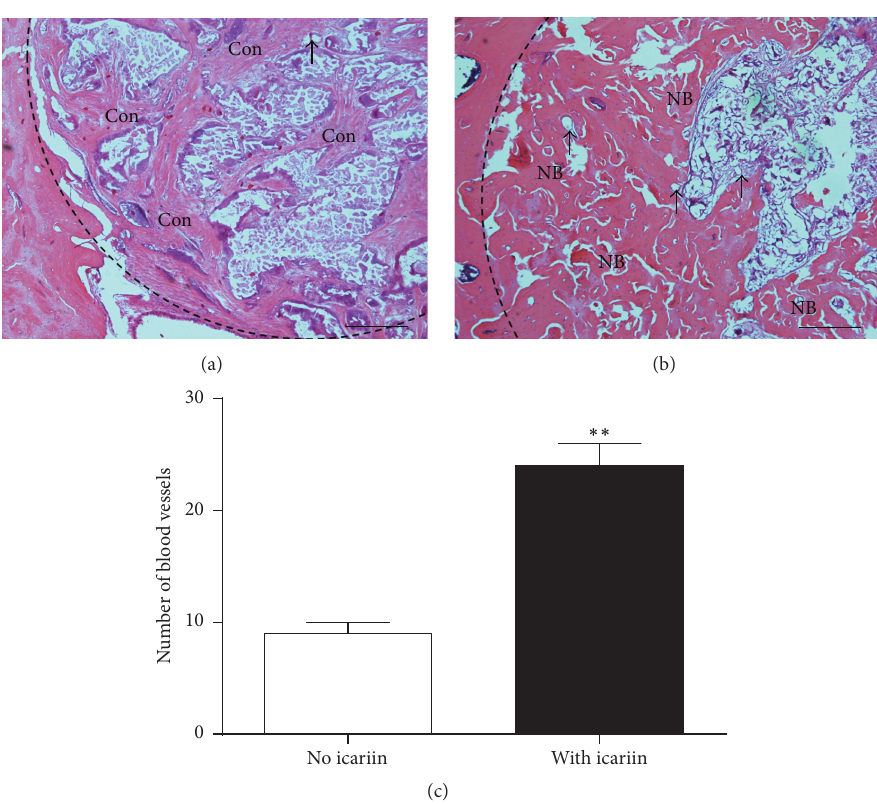
Figure 9: Light micrographs depicting the new bone formation within the calvarial critical-size bone defects that were treated with SMC- PHBHHx/allogeneic BMSCs either (a) without or (b) with icariin. Bar = 200 𝜇 m. Then all data are presented as mean values together with the standard deviation (SD). NB: new bone; Con: connective tissue; black arrow: blood vessels. (c) Graph depicting the number of vessels per section. All data are presented as mean values together with the standard deviation (SD). ∗∗ 𝑝 < 0.01